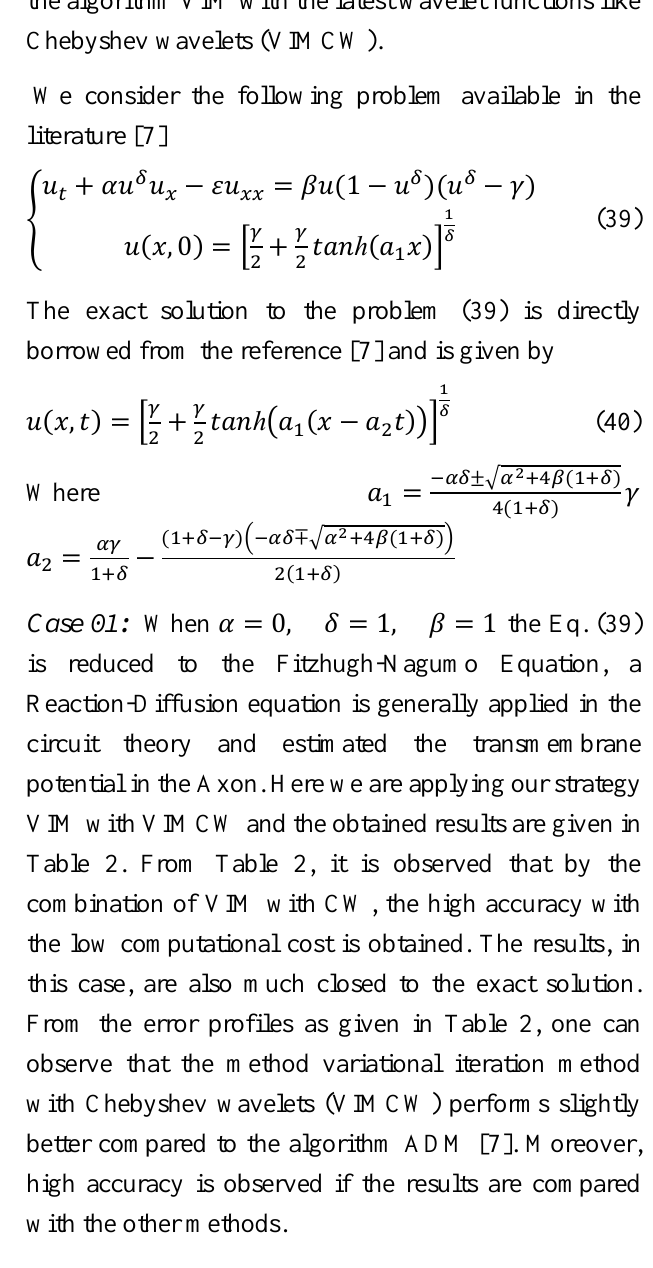
Fig. 3. Plot of Eq. (47) by